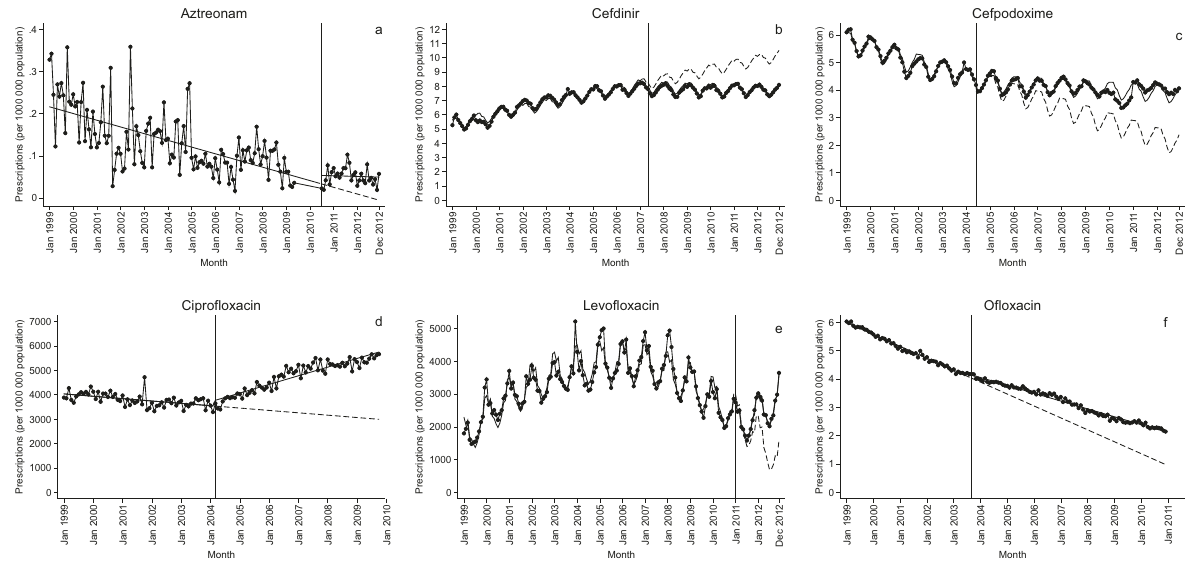
Fig. 1 Antibiotics showing a signi fi cant level increase/decrease within two years after generic entry. Change in number of antibiotic prescriptions per one million population before and after generic entry (vertical line), with projected level of prescriptions if generic entry had not taken place (dashed line). a Aztreonam. b Cefdinir; note logged data. c Cefpodoxime; note logged data. d Cipro fl oxacin. e Levo fl oxacin. f O fl oxacin; note logged data.